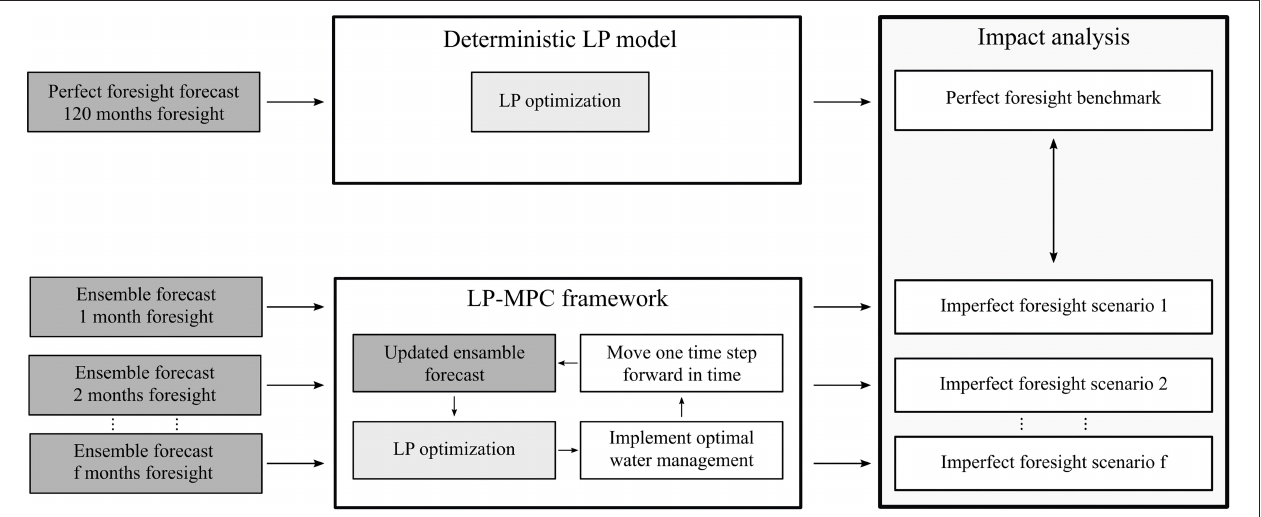
FIGURE 4 | Conceptual illustration of the model framework for the impact analysis of imperfect foresight vs. perfect foresight. Model outputs from the statistical forecast model are shaded in dark gray whereas the process of optimization with the deterministic LP hydroeconomic model is shaded in light